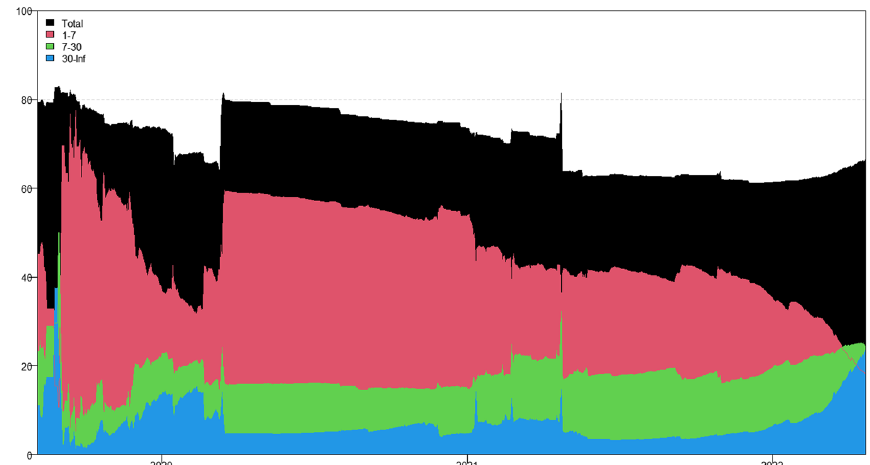
Fig. 23 Dynamic total connectedness—realized negative semivariance (RSV-N)